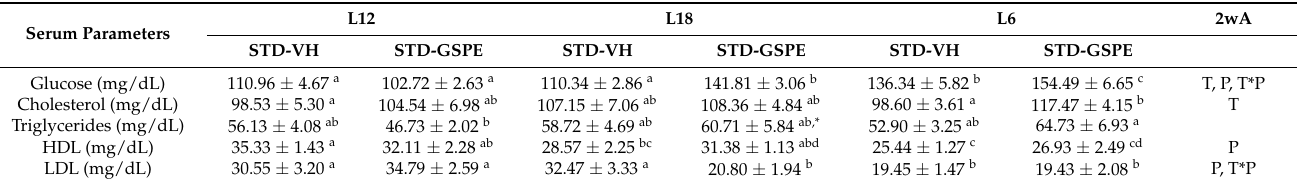
Table 2. Concentration of serum parameters in response to different photoperiod exposure and GSPE treatment in animals fed a STD diet for 9